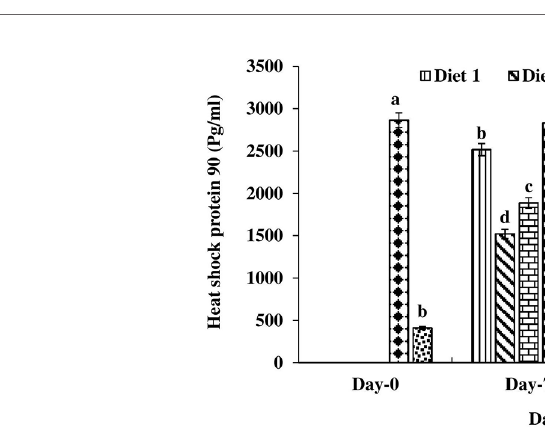
FIGURE 8 | Heat shock protein (Hsp) 90 level found in four different diets fed UV-B exposed and unexposed Catla catla . Bars with different superscripts (a-e) are signi fi cantly different (n